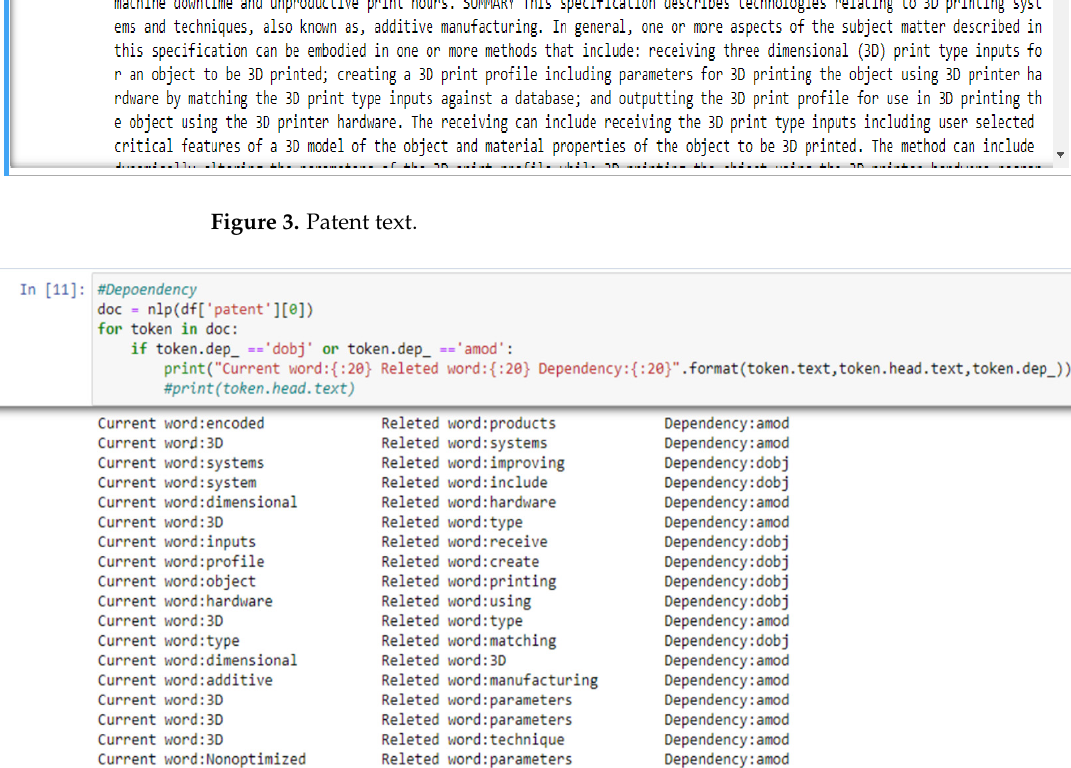
Figure 3. Patent text.